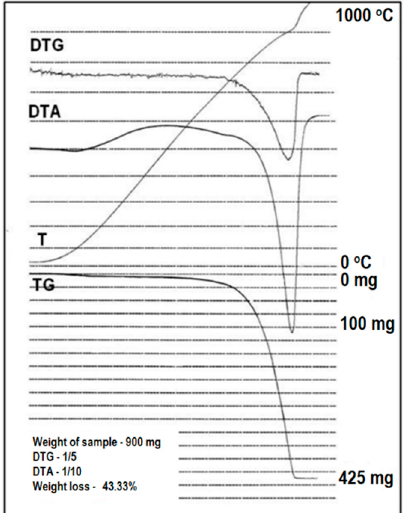
Figure 8. Derivatogram of sample SA2, limestone of the Karchowice Unit taken in the area of Saint Anne Mountain [21].